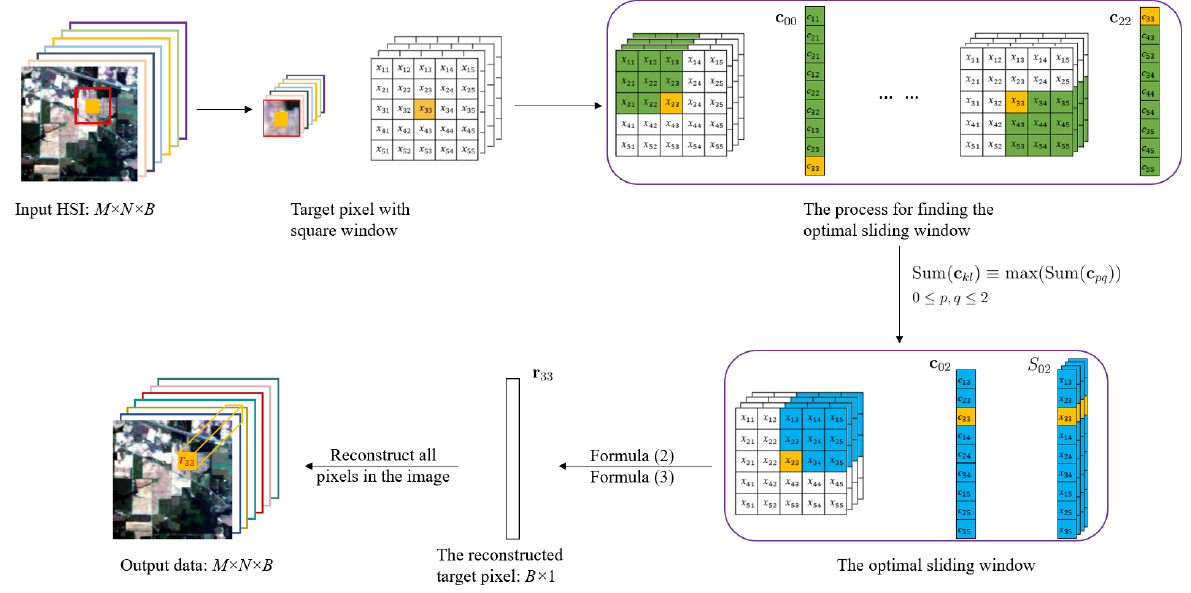
Figure 2. The illustration diagram of the NSW method [36]. The yellow square x 33 represents the target pixel and the yellow square c 33 represents the correlation coefficient of x 33 with itself. The green squares represent the neighboring pixels in the sliding windows and their corresponding correlation coefficients. The blue squares represent the optimal sliding window and the corresponding correlation